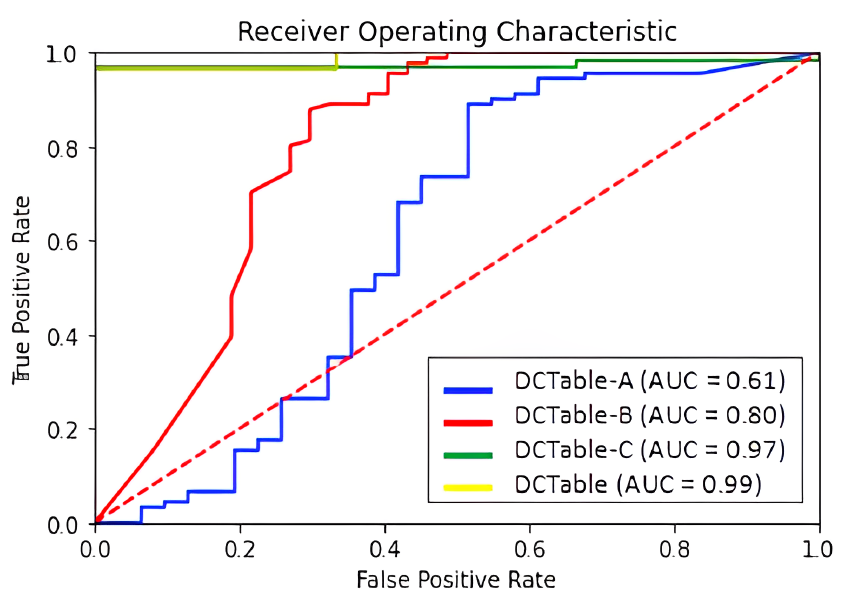
Figure 12. ROC curve for RVL-CDIP dataset.